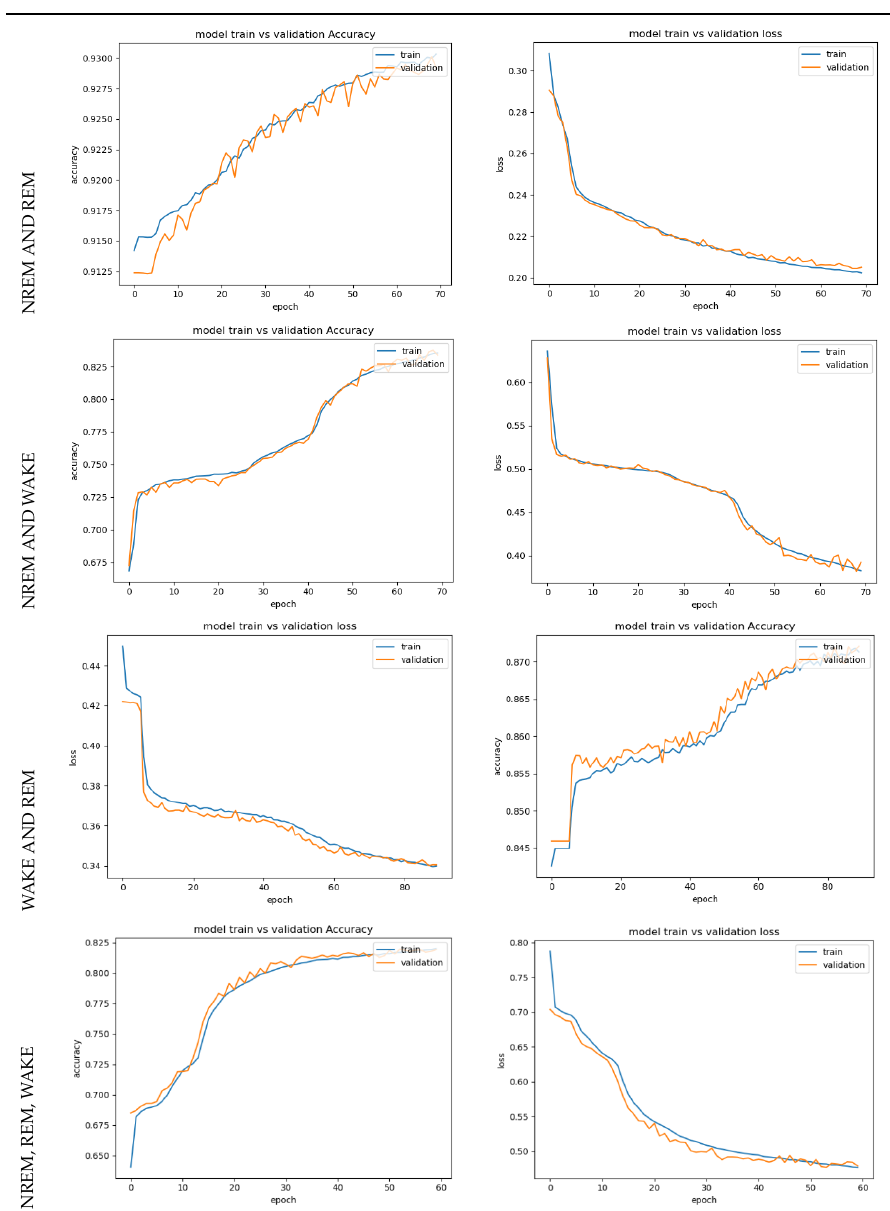
Table 8. Validation loss and accuracy for a single PC-FC